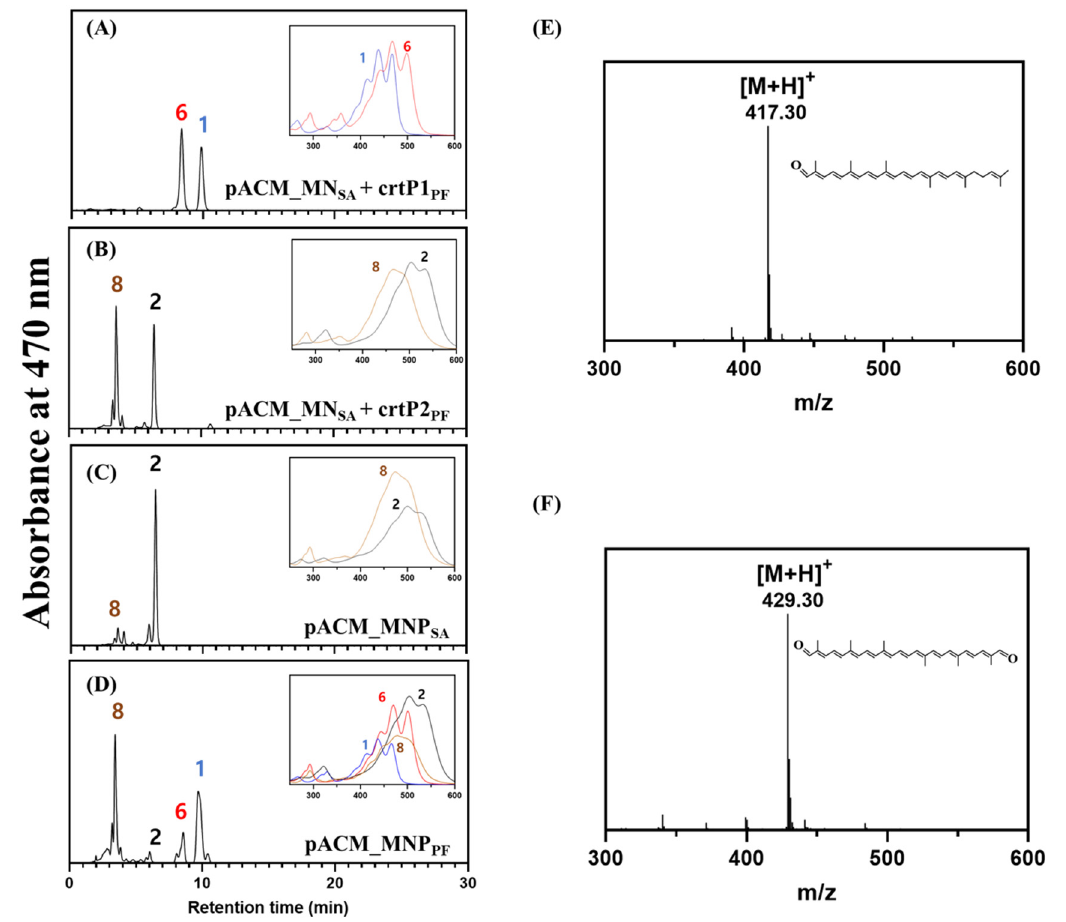
Functional analysis of CrtP2 enzyme in heterologous E. coli and LC-MS analysis. HPLC analysis of cell extracts of recombinant E. coli expressing ( A ) crtM SA -crtN SA + crtP1 PF , ( B ) crtM SA -crtN SA + crtP2 PF, ( C ) crtM SA -crtN SA -crtP SA of S. aureus (as a positive control), and ( D ) crtM PF -crtN PF -crtP PF . The insert UV / VIS spectra in the panels ( A – D ) correspond to peaks in the HPLC chromatogram. The peak numbers (1, 2, 6 and 8) refer to the corresponding structures in Figure 1B. LC-MS analysis of ( E ) 4,4 ′ -diaponeurosporene-4-al (2; [M + H] + = 417.30) and ( F ) 4,4 ′ -diapolycopene-dial (8; [M + H] + = 429.30).